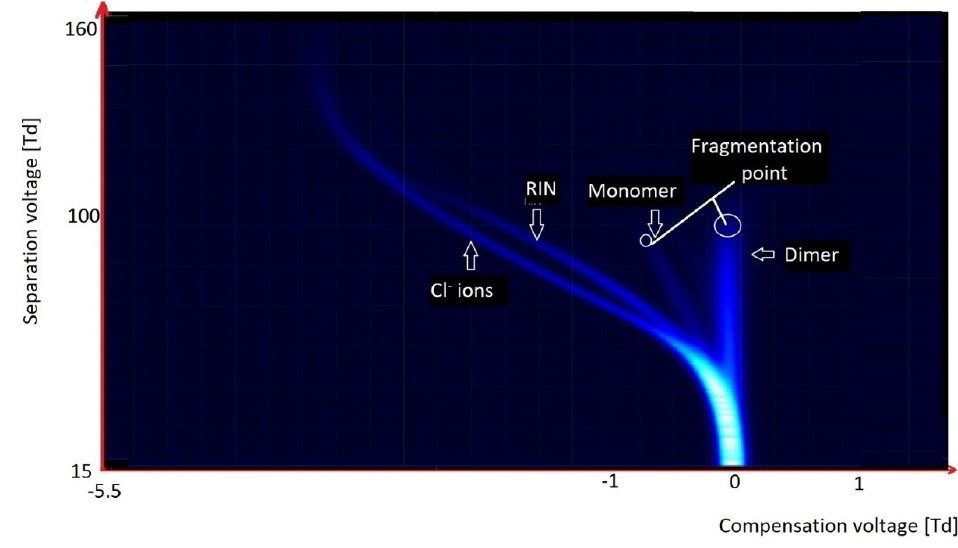
Figure 13. DMS spectrogram of hexachloroacetone.